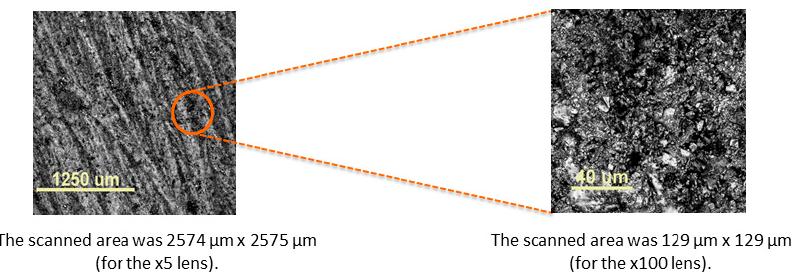
Figure 5. Images taken with a confocal optical microscope (COM). The scanned area